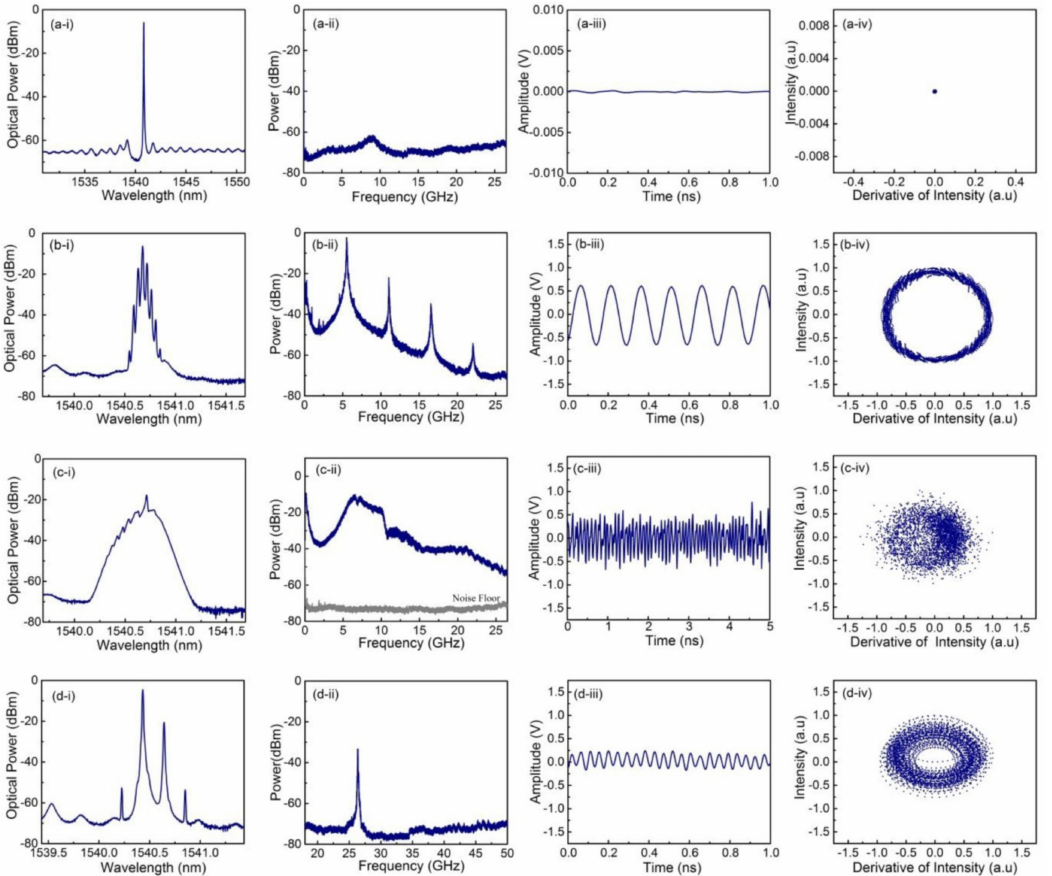
Figure2. Variousdynamicstatesoftheoutputoftheintegratedlaser-photodetectorchipatV PD = − 2.5 V, I DFB = 78 mA, I Phase = 3 mA when I A varies from top to bottoms as ( a ) 0 mA (S state); ( b ) 9 mA (P1 state); ( c ) 18.5 mA (C state); ( d ) 24.5 mA (D state). ( a-i )–( d-i ): optical spectra, ( a-ii )–( d-ii ): RF spectra, ( a-iii )–( d-iii ): temporal waveforms, and ( a-iv )–( d-iv ): phase portraits of various dynamic states,